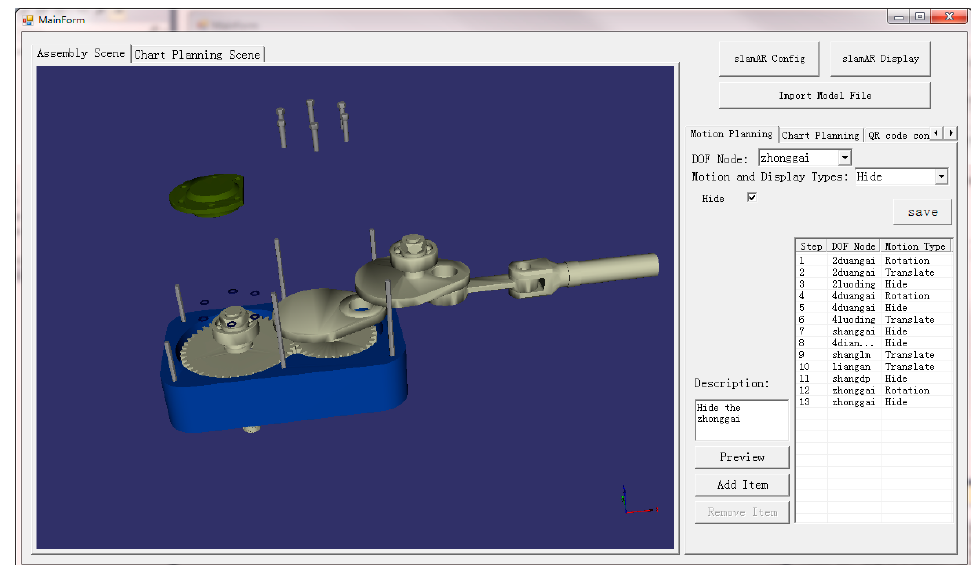
Figure 2. Disassembly animation planning interface of assembly.